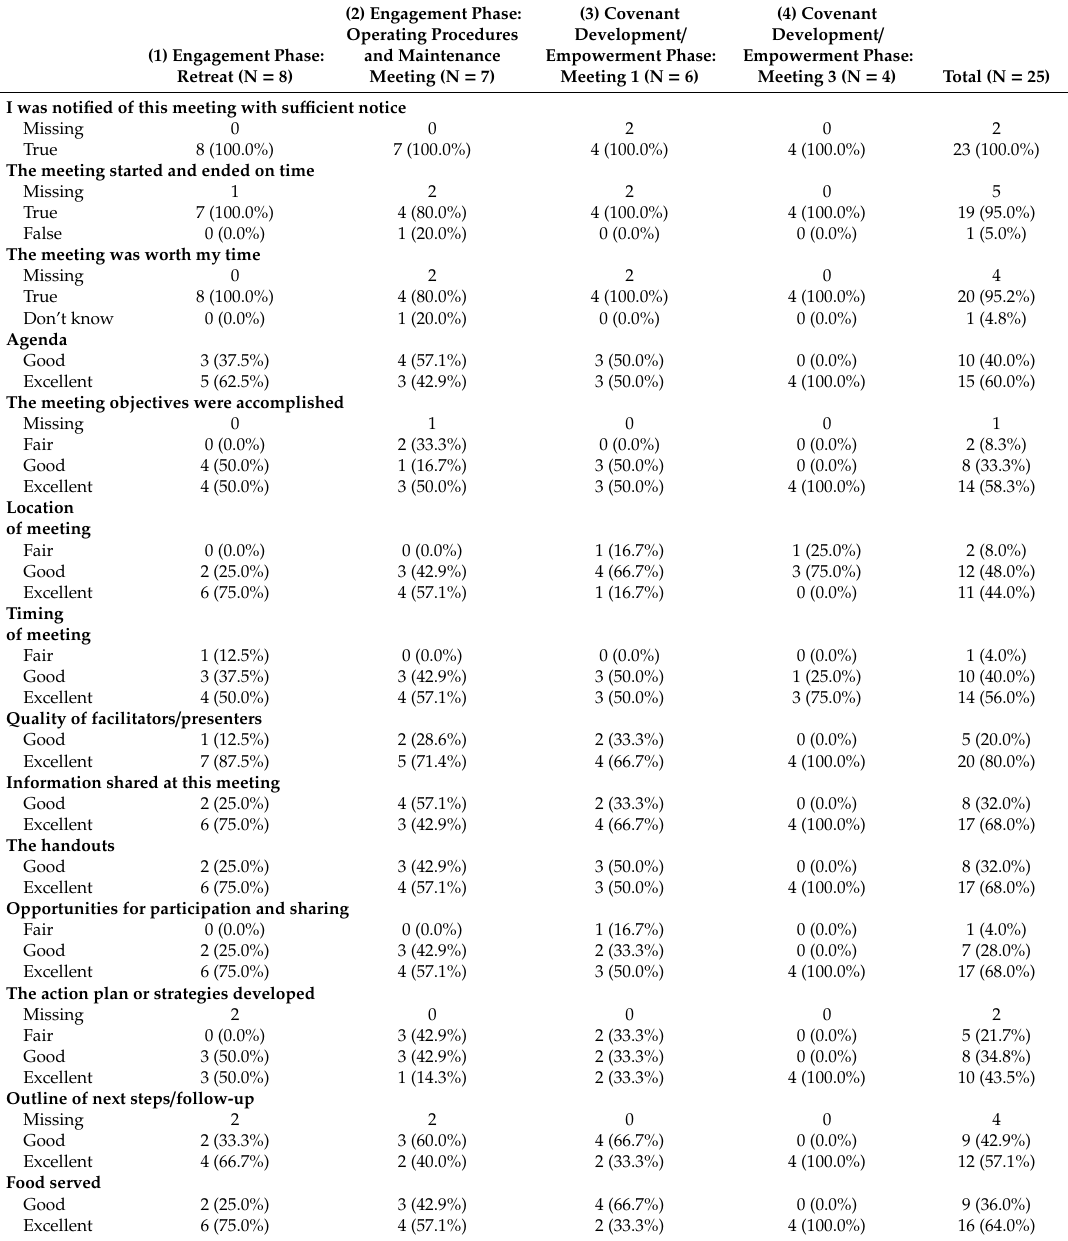
Table 2. FAITH! Community Steering Committee meeting evaluations: summary of responses by